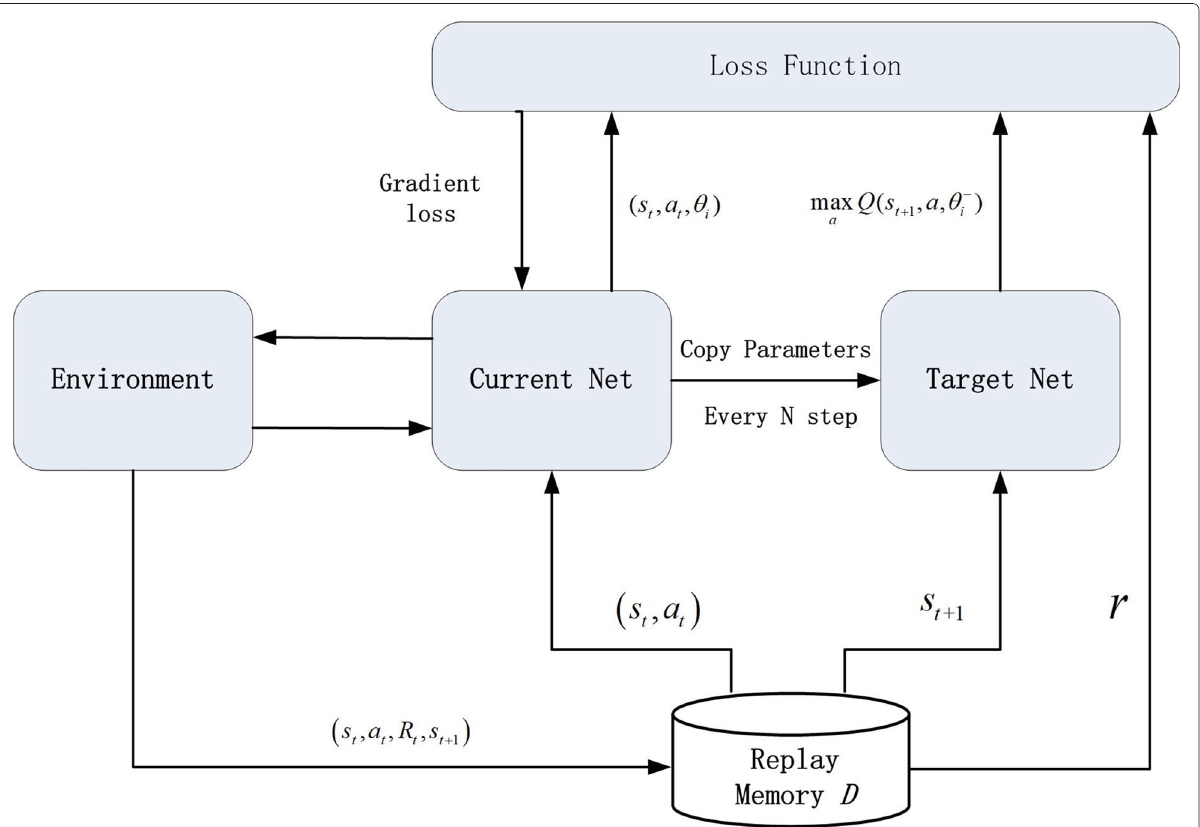
Fig. 2 The DQN-based workload scheduling scheme